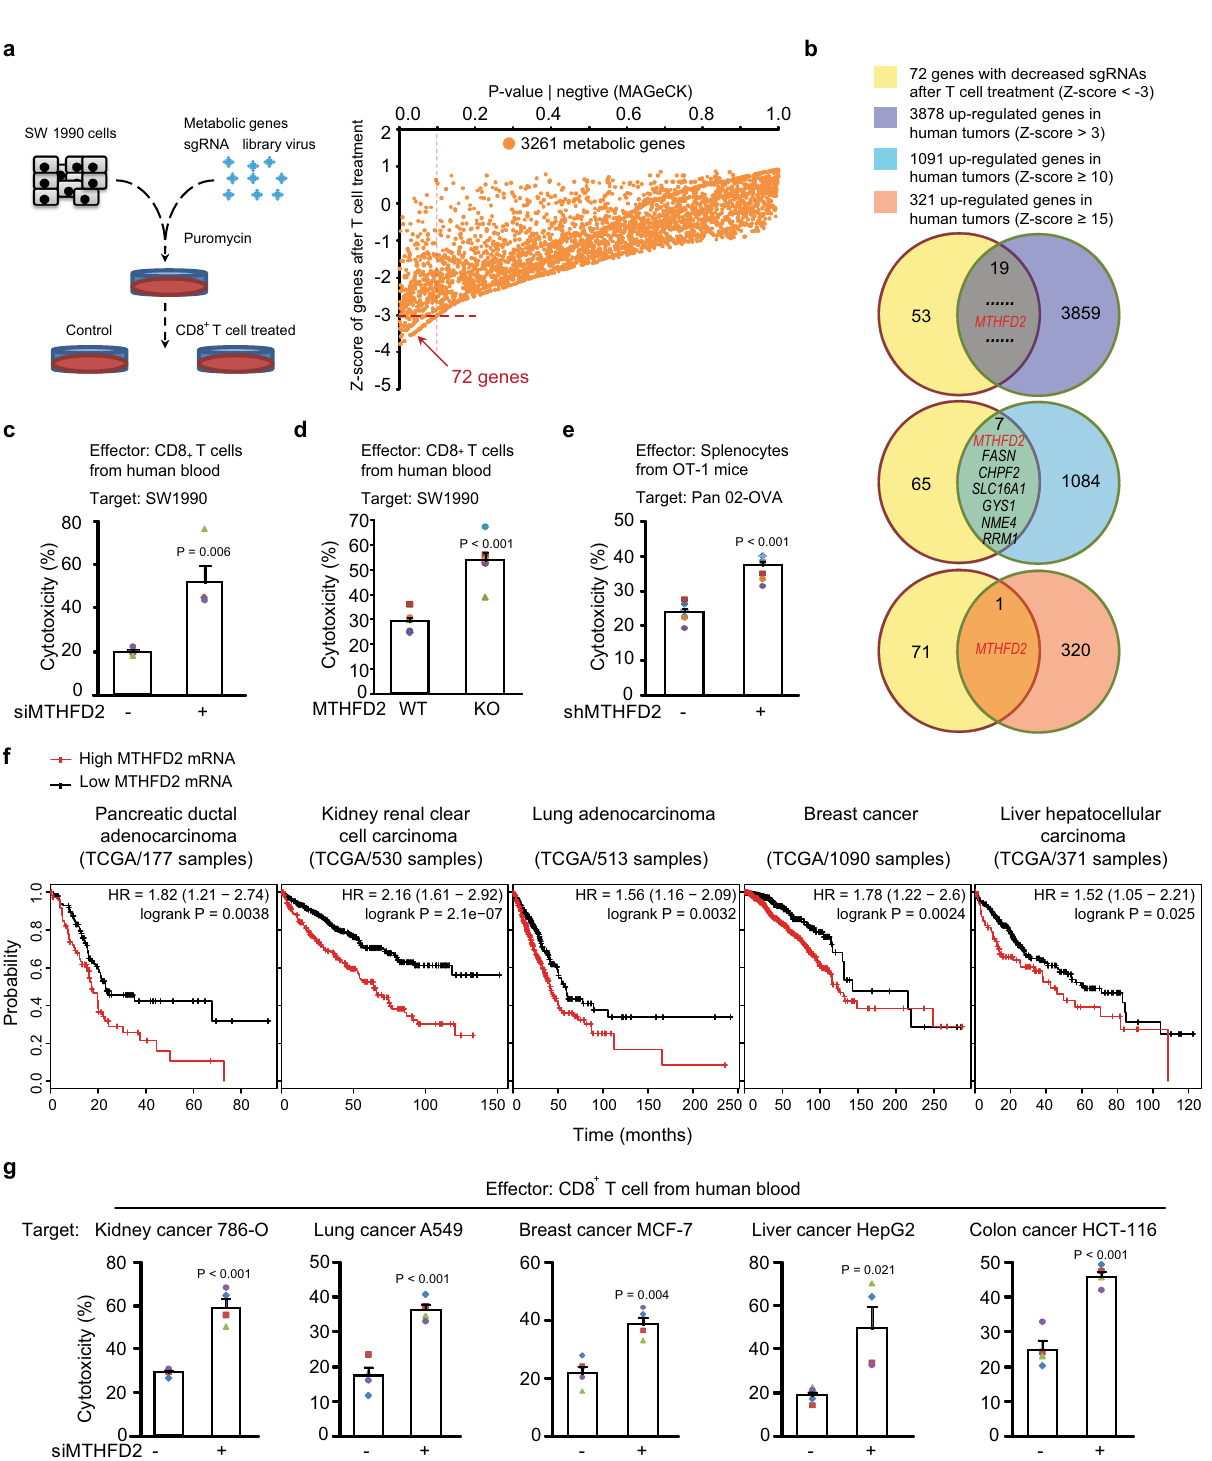
the roles for MTHFD2 in human tumourigenesis is to promote tumor immune evasion. MTHFD2 promotes tumor immune evasion via upregulating PD-L1 expression . To explore the mechanism for the role of MTHFD2 in immune evasion, we analyzed the transcriptome in MTHFD2-KD SW1990 cells by RNA-seq. GSEA analysis 21 in the MSigDB C4 (cancer modules) database showed that the geneset of “ immune response ” was enriched in KD cancer cells (Fig. 2a),